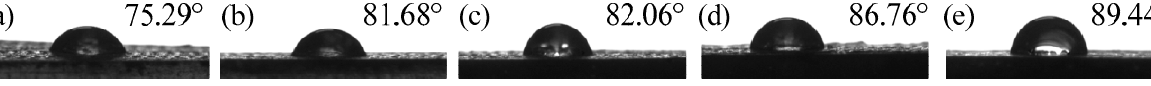
Figure 4. Contact angle of ( a ) curing agent 8%, ( b ) curing agent 10%, ( c ) curing agent 12%, ( d ) curing agent 14%, ( e ) curing agent